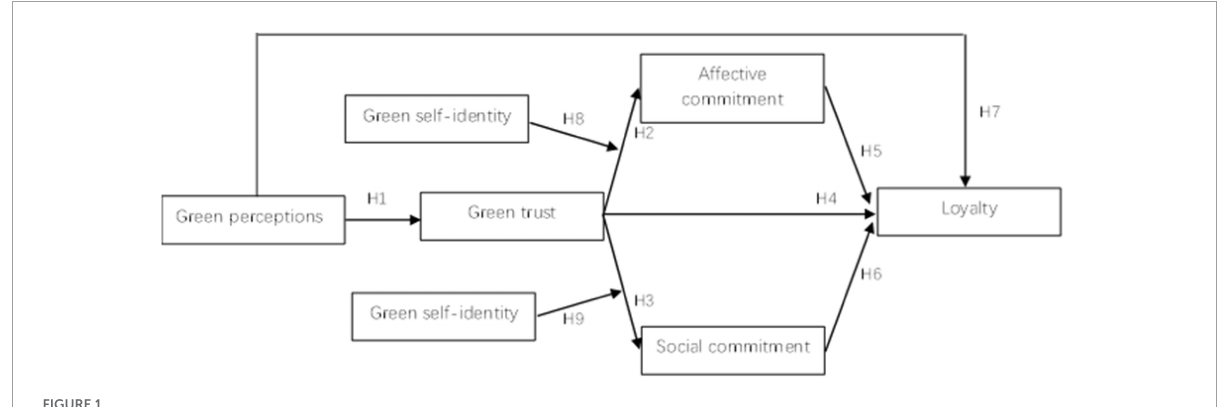
FIGURE1 The theoretical